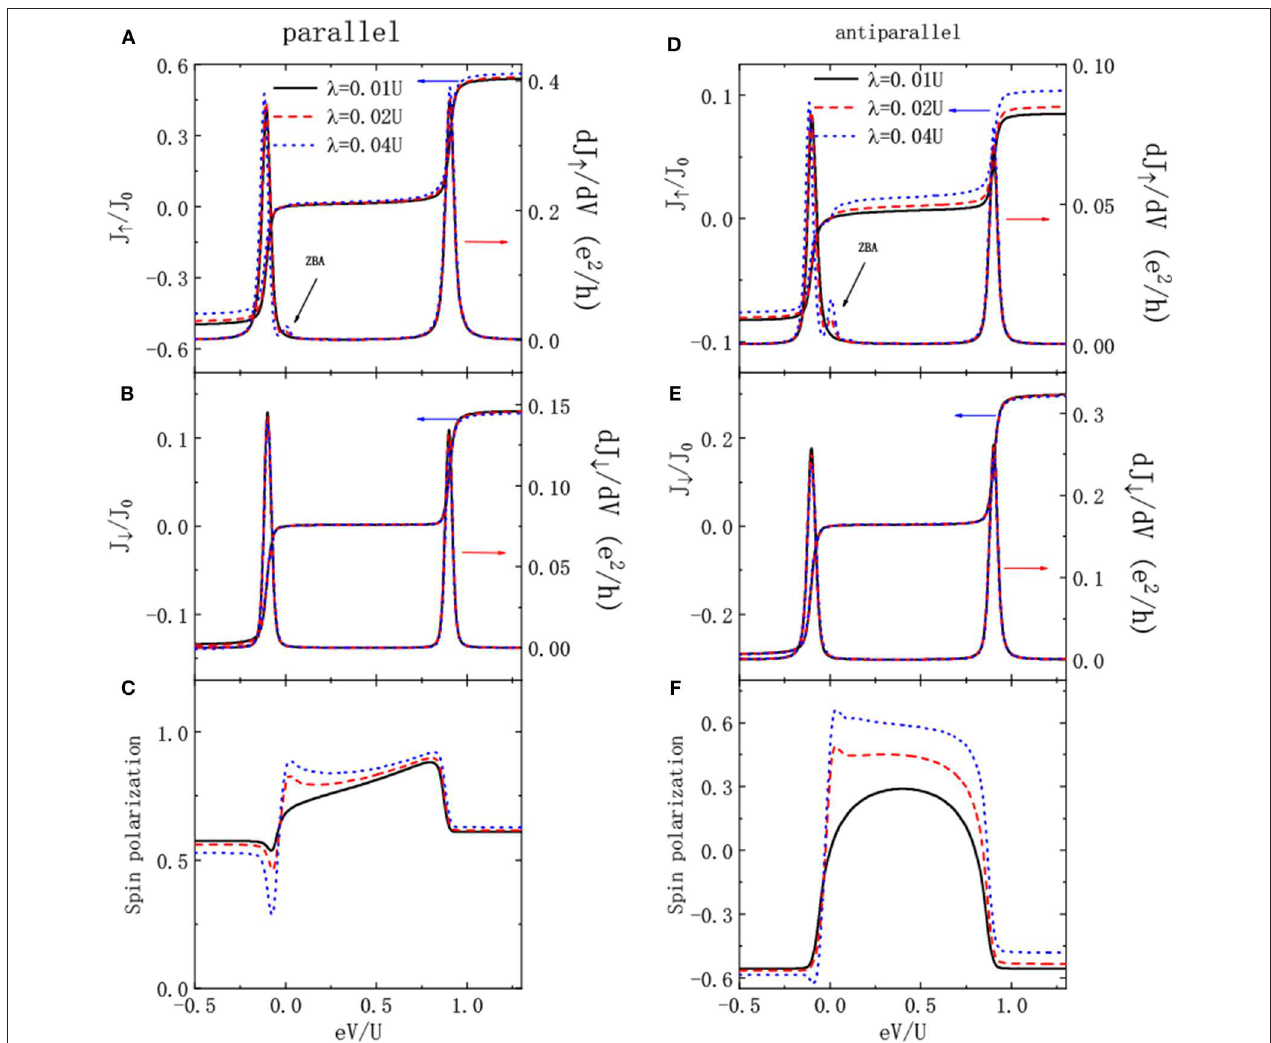
FIGURE 2 | Spin-resolved current, non-linear differential conductance, and current’ spin polarization as functions of the bias voltage when the magnetic moments of the leads are arranged in parallel (A–C) , and antiparallel (D–F) configurations for indicated QD-MBS coupling strength λ 1 k B T P R ε d Ŵ R 0.1, Ŵ L 0.01 U , P L 0.6 ( for parallel and antiparallel cases, = − = = = = ± = ±